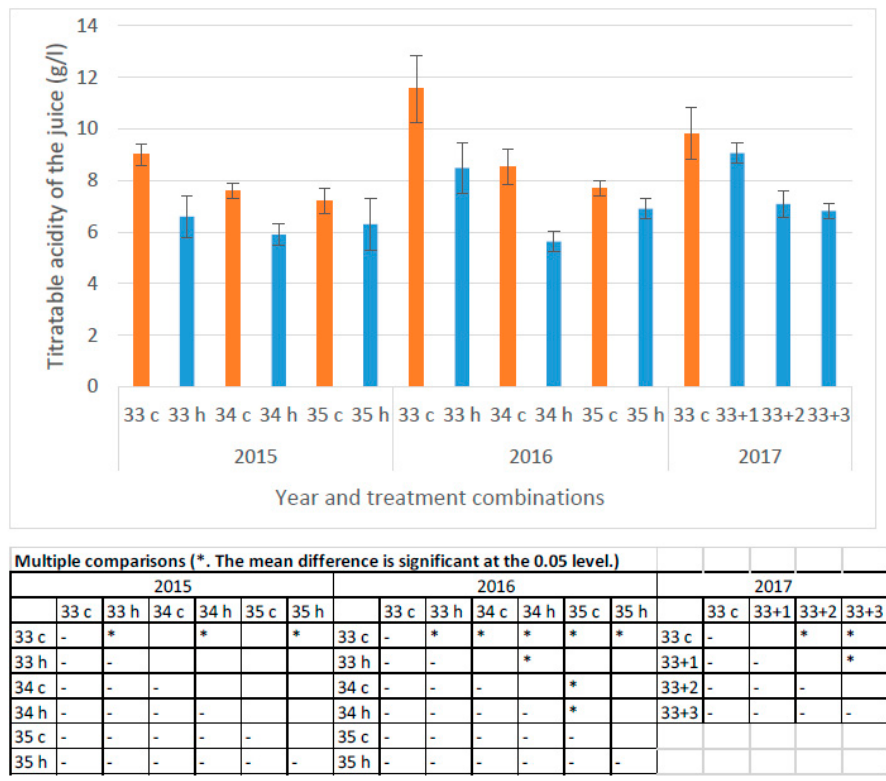
Figure 4. The effect of the different DMR treatments on the titratable acid content of the juice (g/L).